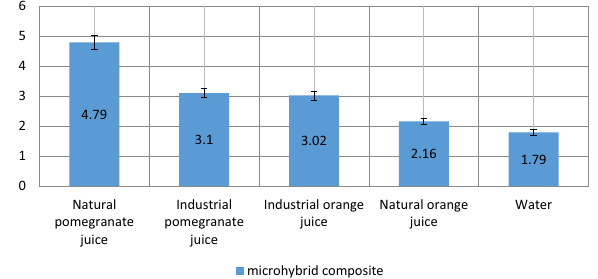
Fig. 1 Mean discoloration of microhybrid composites exposed to different beverages. Table 2. Comparing discoloration rate of nanohybrid composite exposed to natural and commercially-produced juices. Variable